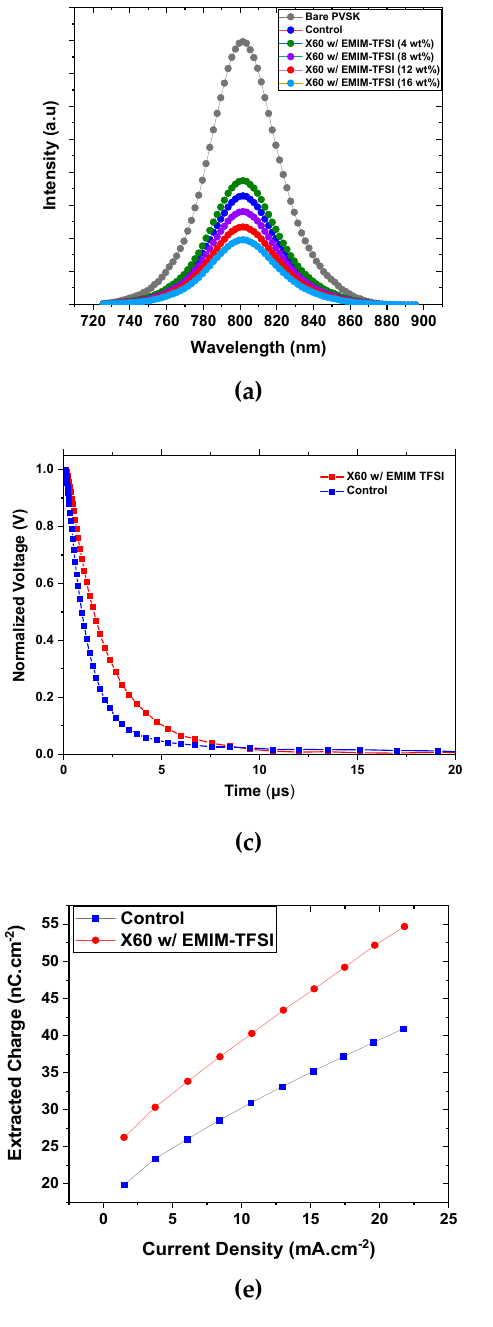
Figure 5. ( a ) Steady-state photoluminescence of ITO/perovskite samples without HTL, covered with X60 doped with Li-TFSI and covered with X60 doped with EMIM-TFSI (12 wt%). Characterization of control and EMIM-TFSI-doped X60 devices: ( b ) dark J–V curves of hole only devices, ( c ) transient photovoltage (TPV) curves, ( d ) Mott–Schottky analysis, and ( e ) extracted charge estimation from TPC measurements for the completed best performing devices.